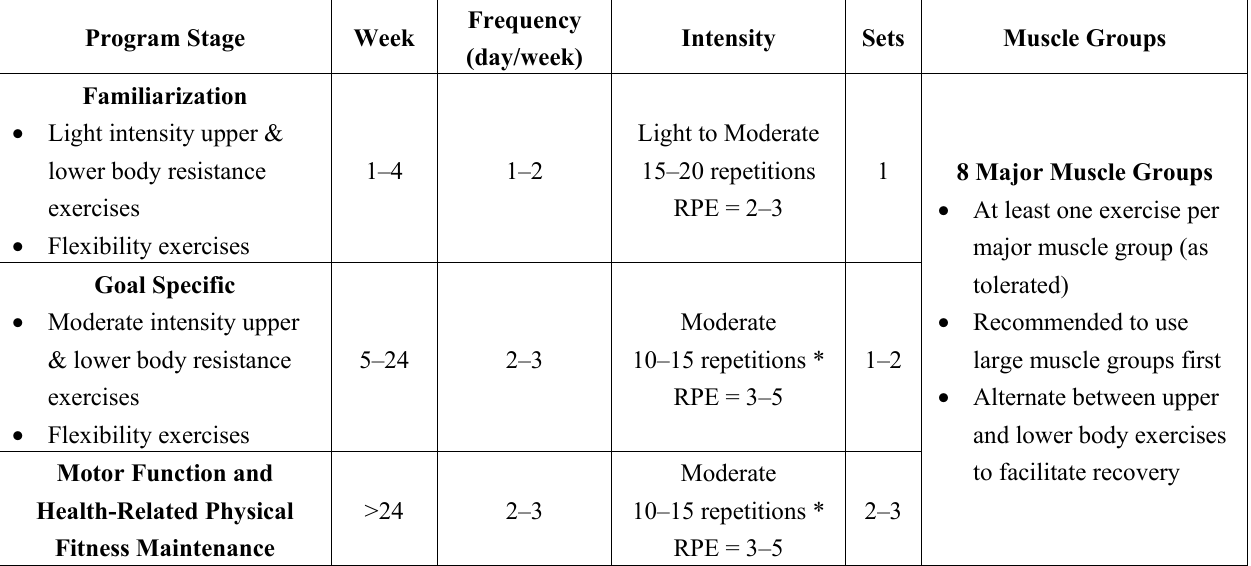
Table 3. Example resistance training program for persons living with schizophrenia. Adapted from